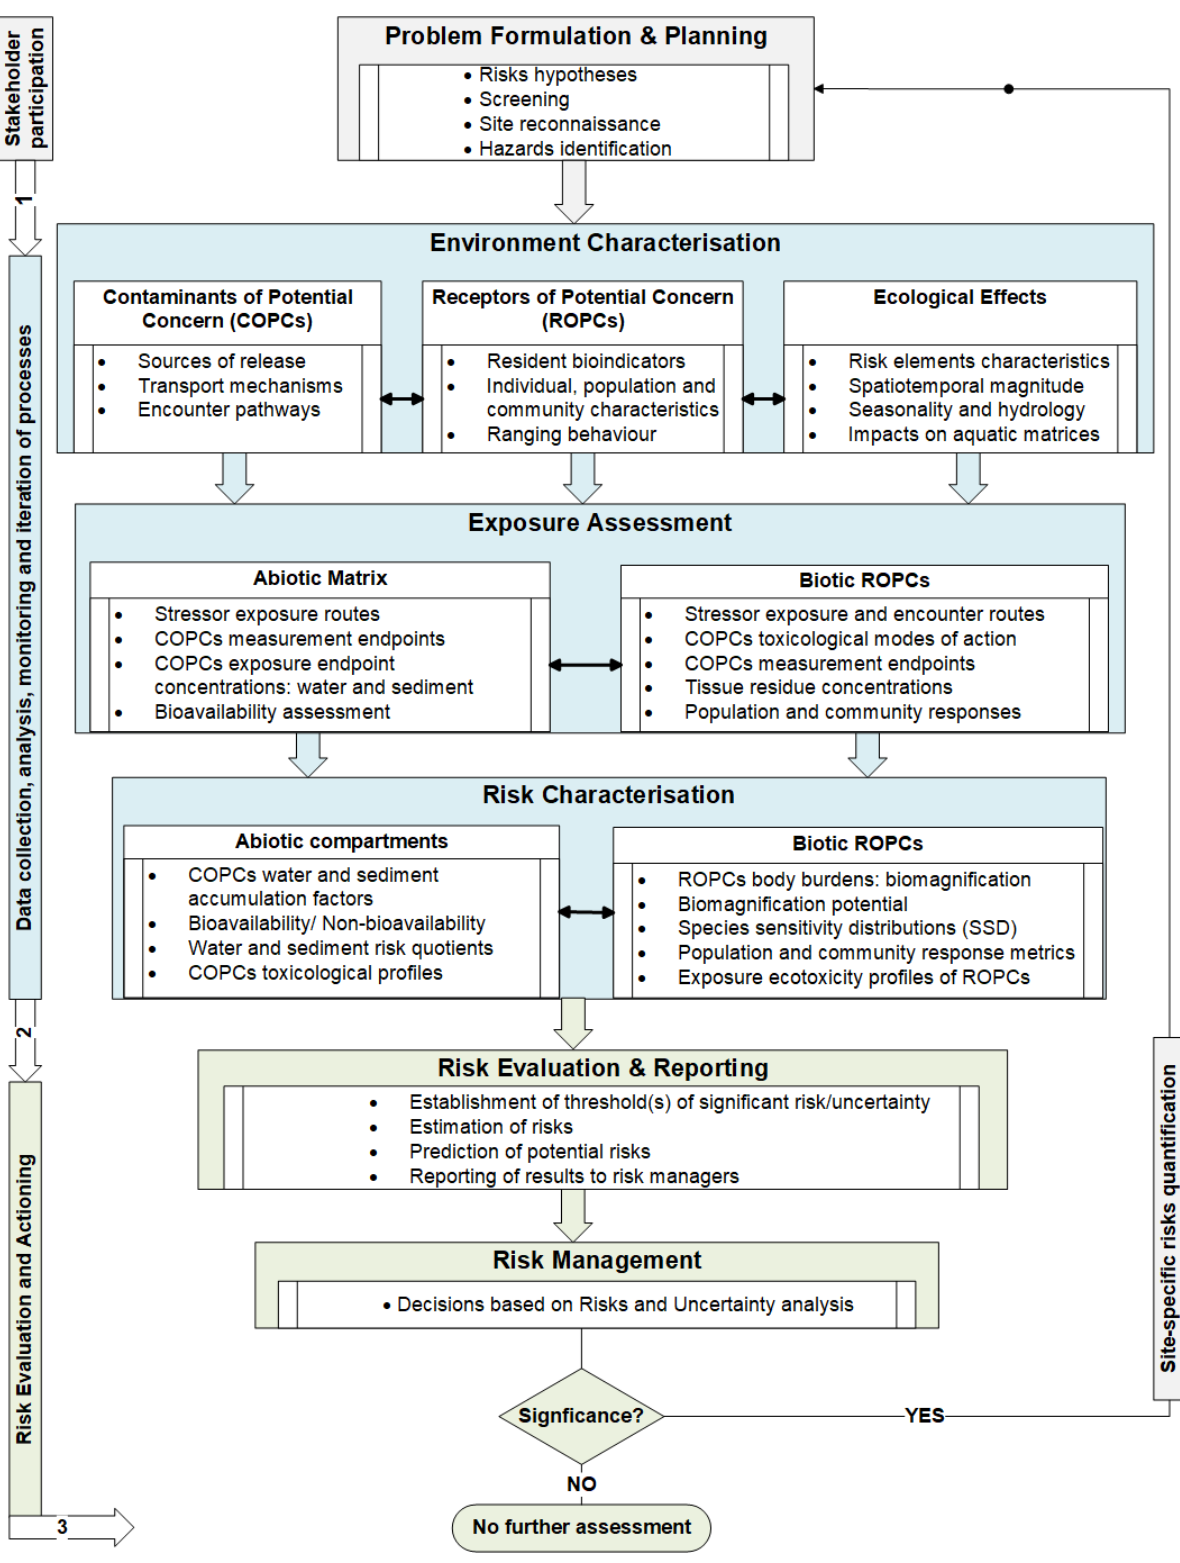
Figure 4. A conceptual framework to assess the potential ecological risks to aquatic systems draining heavy-metal mining landscapes.